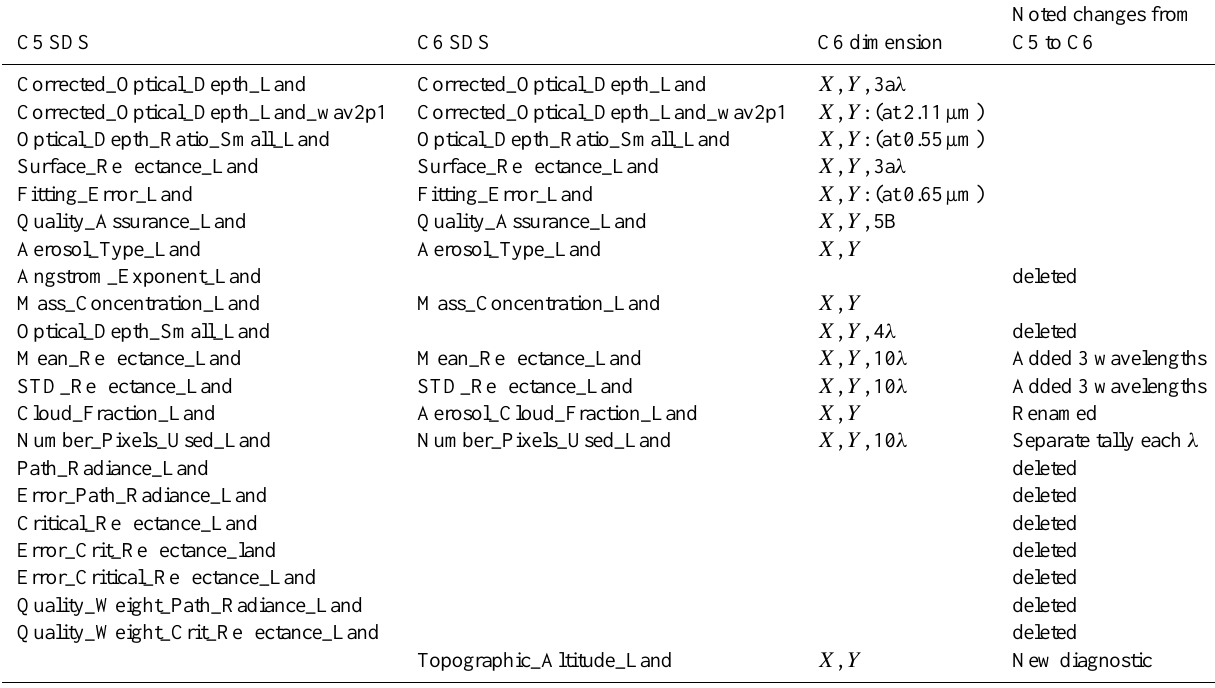
Noted changes from